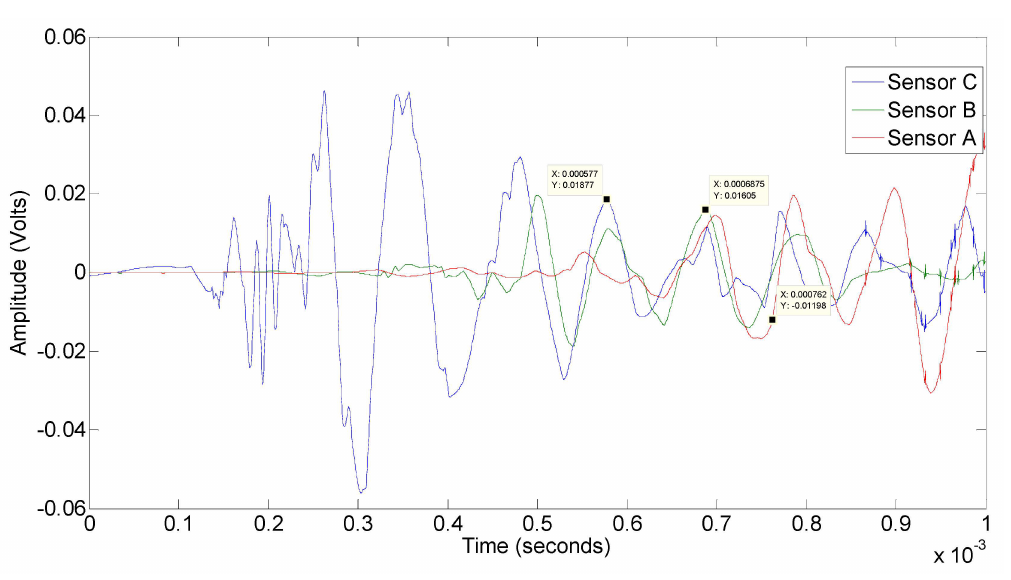
Figure 4. Pre-processing of the signal. Wave front collected by Sensors C ( blue ), B ( green ) and A ( red